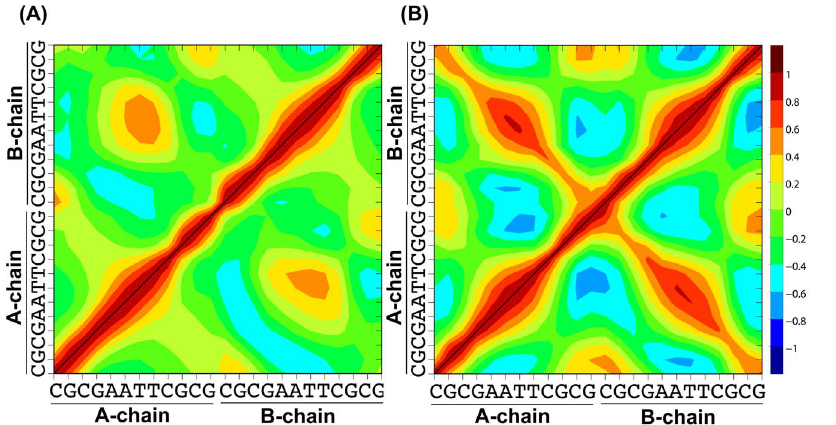
Figure 7. The cross-correlation matrix elements in the fluctuations of (A) the DNA backbone heavy atoms, and (B) the base heavy atoms, averaged along the trajectories of the last 7 ns of the total 10 ns MD simulations. The cross correlation values from 1.0 to –1.0 are colored red (positive) to blue (negative). The lower triangles show the values obtained by the PME method ( r c =12 A˚ and a =0.35 A˚ 2 1 ), and the upper triangles show the correlations provided by the ZD method ( r c =12 A˚ and a =0.0), respectively. The A- and B-chains are indicated with the nucleotide abbreviated names.